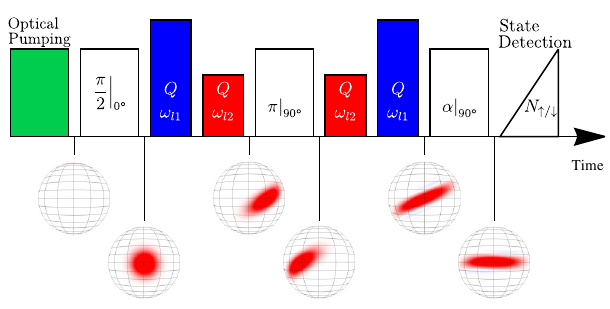
FIG. 10. Full experimental sequence for cavity spin squeezing as used in Ref. [27]. The subscript for the radio-frequency pulses indicates the axis of the rotation. The Bloch spheres below the sequence indicate the collective spin state at the corresponding time.